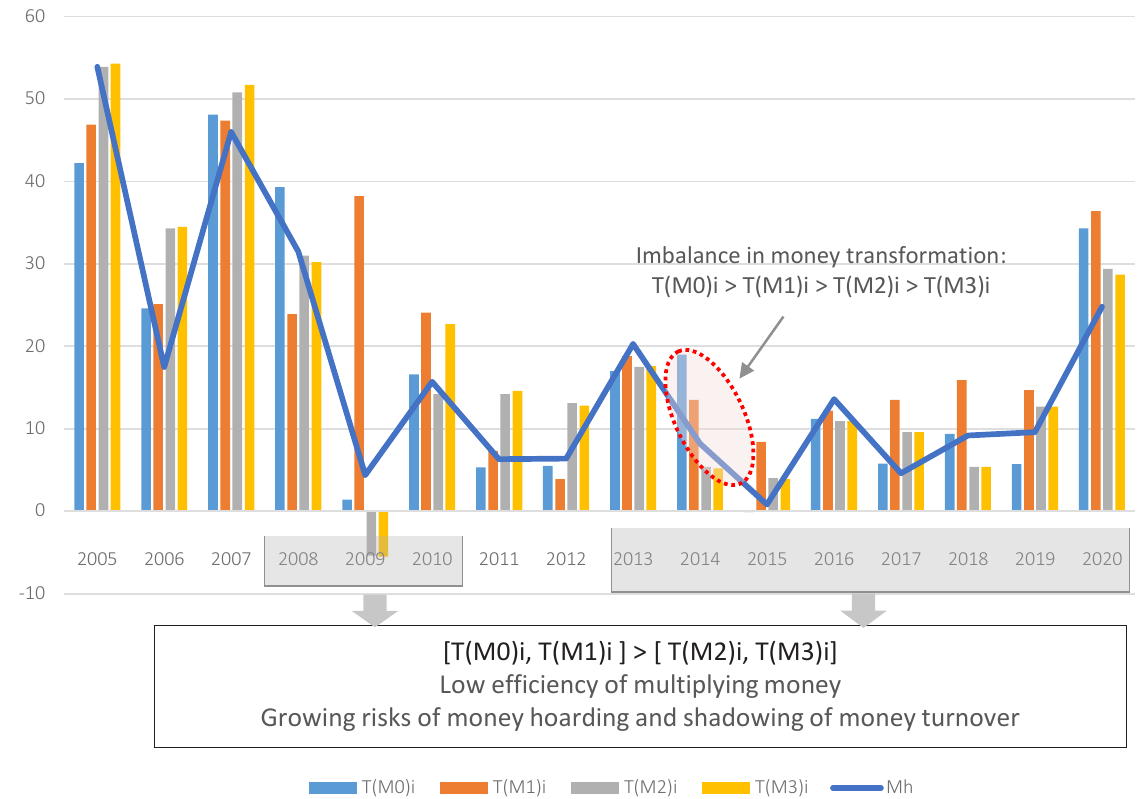
Figure 4. Slowdown and instability of monetary transformation processes in Ukraine in